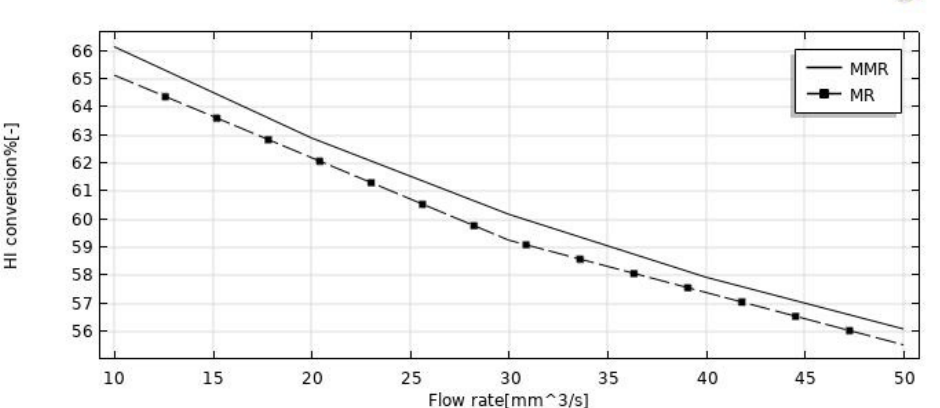
Figure 7. HI conversion vs. the feed flow rate in both the MR and MMR at p = 1 bar, T = 400 °C, and sweep gas flow rate = 333.33 mm 3